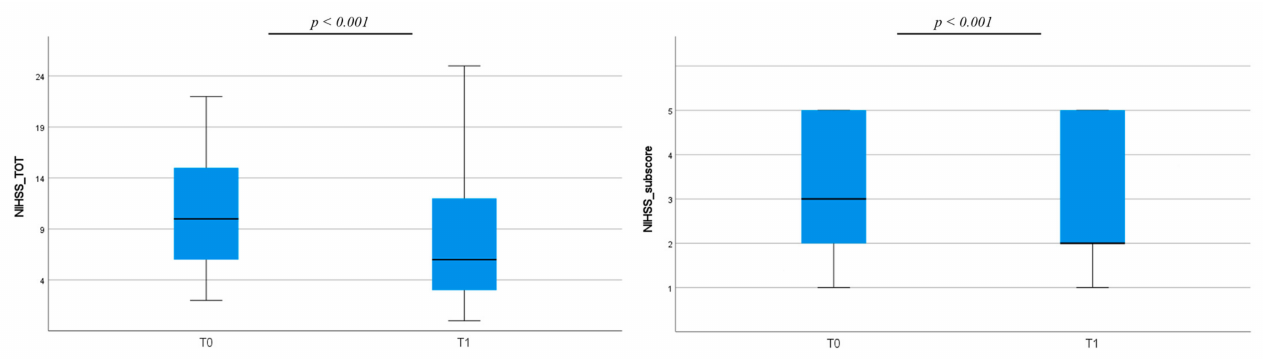
Figure 1. Clinical changes between T0 and T1 as measured by NIHSS total score (on the left). and NIHSS motor sub-score related to the paretic arm (on the right). NIHSS = National Institutes of Health Stroke